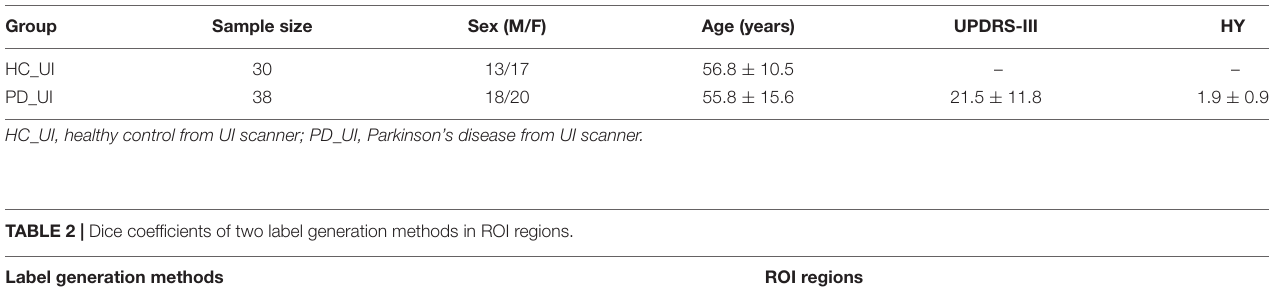
TABLE 1 | Demographic details of participants from UI scanner.